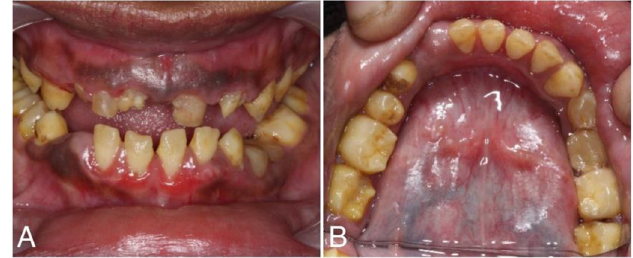
Fig. 1. (A) Clinical photograph showing microdontia, yellow color teeth and chipping. (B) Clinical photograph showing gingival swelling above impacted mandibular right canine.